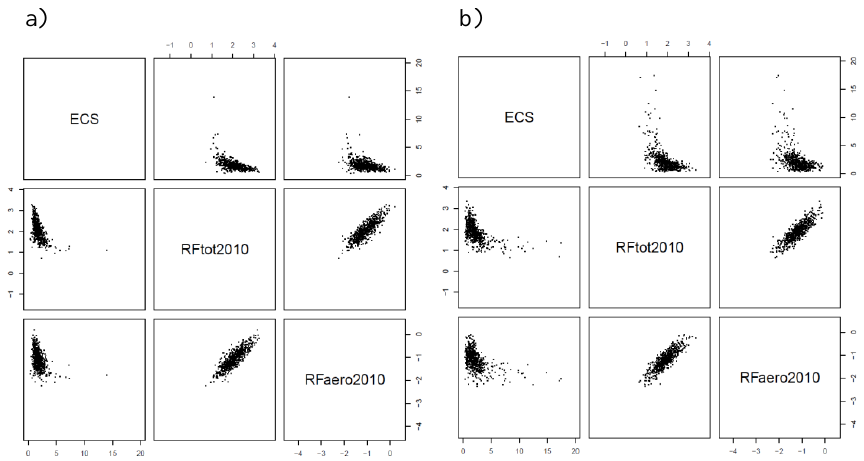
Fig. F1. Pair plots of samples from the posterior distribution for ECS, total RF in 2010 and total aerosol effect in 2010. In (a) the model is updated with data up to 2010, while in (b) the model is updated with data up to 2000.